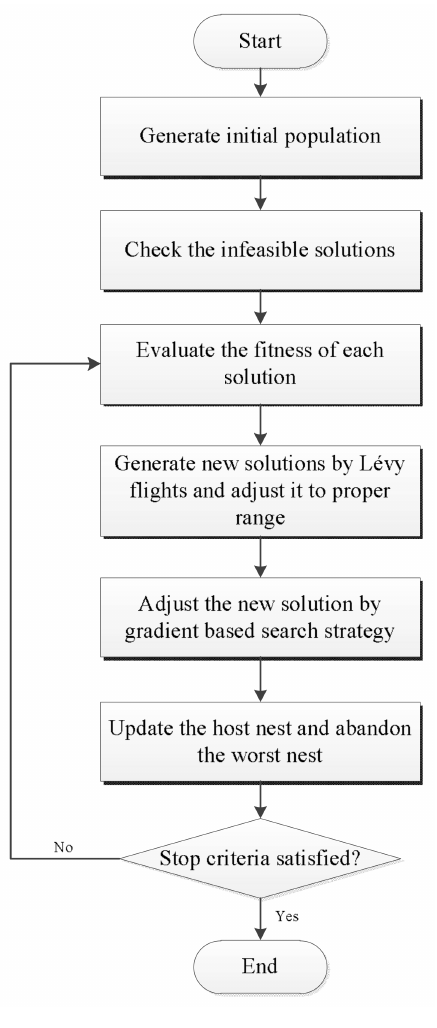
Figure 3. Flowchart of gradient-based cuckoo search